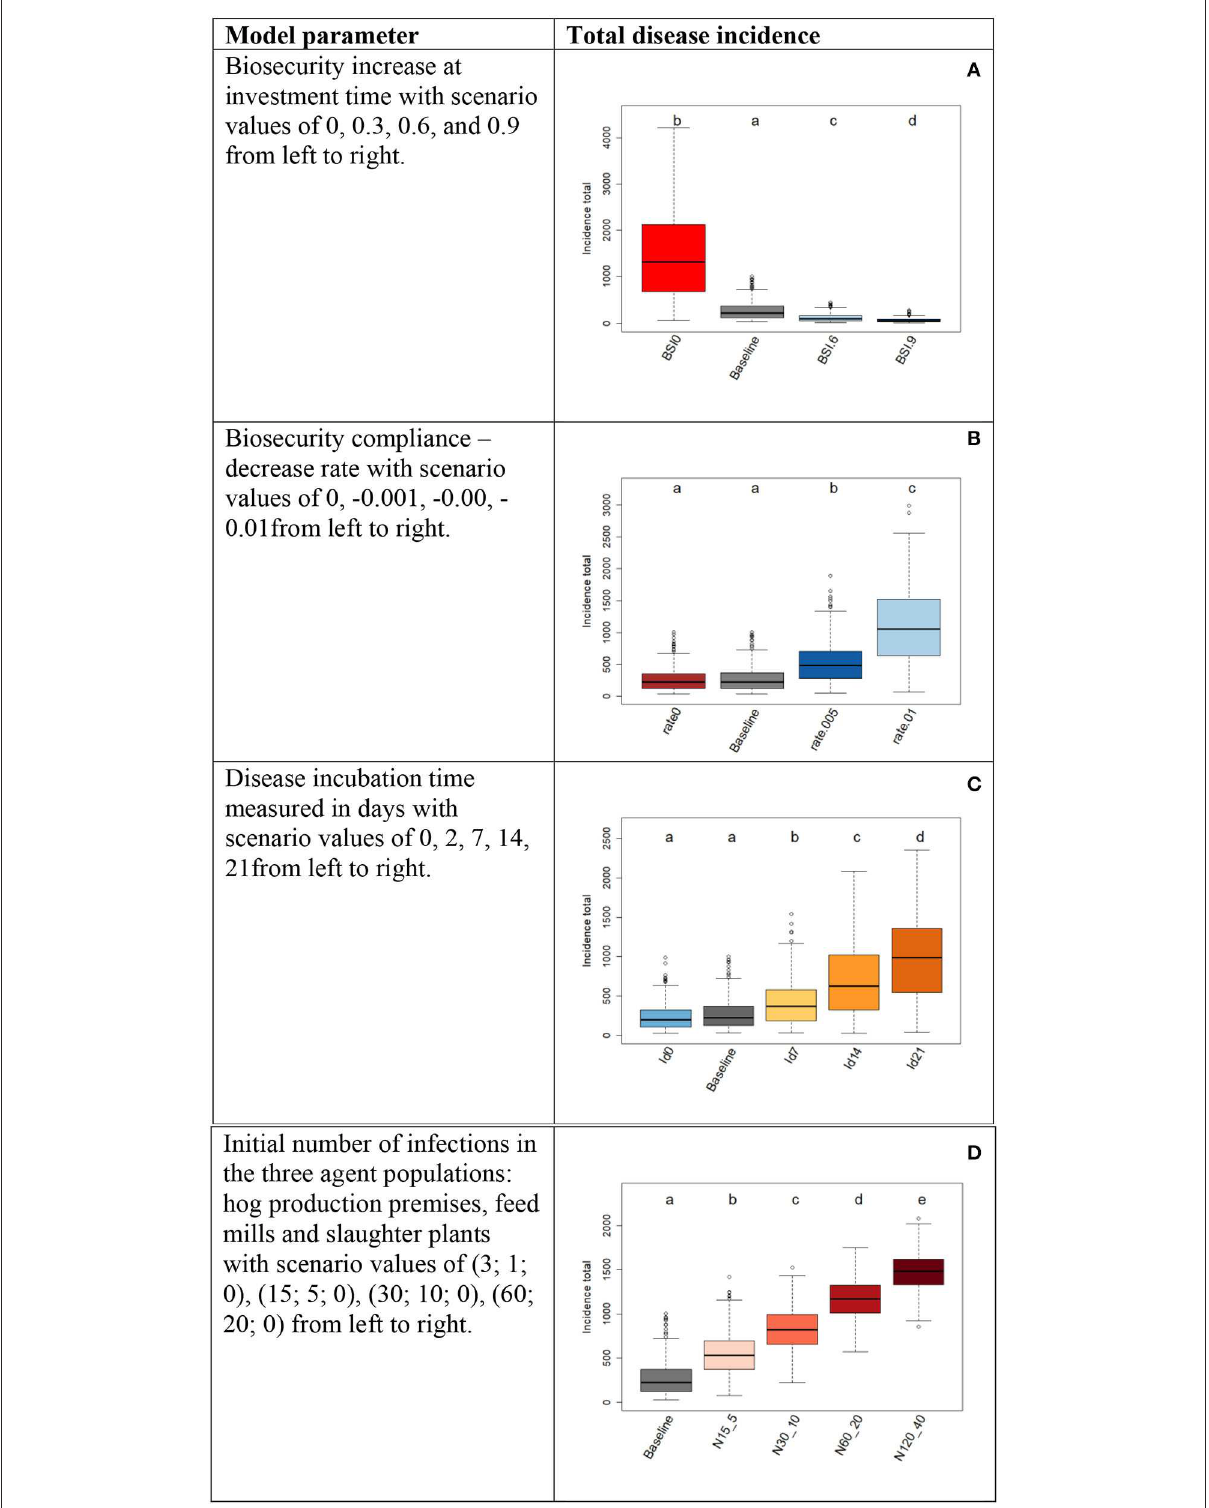
FIGURE4 Results from sensitivity analysis. Each table row represents a sensitivity experiment where one model parameter was varied across a range of values (scenarios) as indicated in the left column. Capital letters distinguish the experiments: (A) for the parameter “Biosecurity increase at investment time”; (B) for “Biosecurity compliance”; (C) for “Disease subclinical incubation time” and; (D) for “Initial number of infections”. Box plots display the distributions of disease incidence totals with letters indicating significance from the pairwise distribution comparisons of scenarios. The baseline was used as reference scenario. Distributions not sharing any letter are different by the two-sample Kolmogorov-Smirnov test at the 5% level of